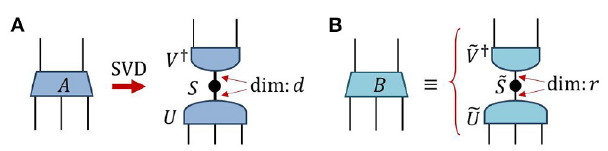
FIGURE 6 | (A) The singular value decomposition is taken on tensor A across a bi-partition between its top two and bottom three indices, and is assumed to produce d non-zero singular values. (B) Tensor B is now defined by truncating the matrix of singular values S → ˜ S to retain only r < d of the largest singular values, while similarly truncating the matrices of singular vectors, U → ˜ U and V → ˜ V , to retain only the corresponding singular vectors. By the Eckart–Young–Mirsky theorem [76] it is known that B is the optimal rank- r approximation to A (across the chosen bi-partition of tensor